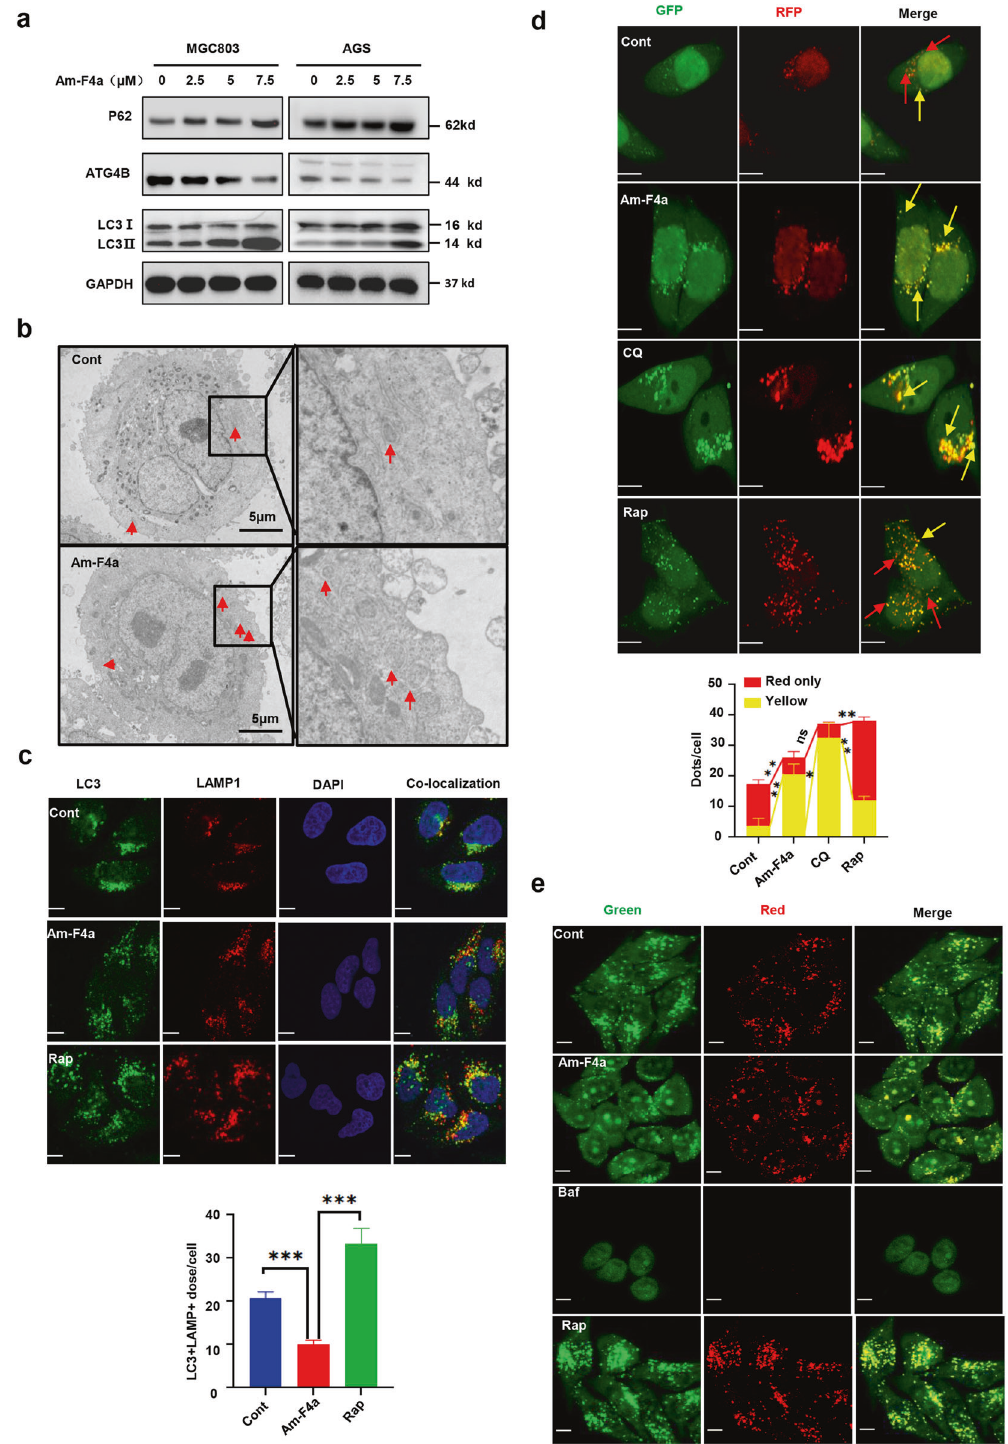
Fig. 3 Am-F4a suppresses autophagy fl ux in cells. a Immunoblotting analysis of indicated protein in MGC803 and AGS cells treated with Am- F4a for 48 h. Representative blots, n = 3. b Representative images of transmission electron microscopy (TEM) exhibit ultrastructure of MGC803 cells treated with or without Am-F4a (10 μ M) for 6 h. Red arrows indicate normal autophagosome structures. c Hela cells were treated with Am-F4a (10 μ M) and Rap (1 μ M) for 6 h. The colocalization of LC3 and LAMP1 puncta was examined and quanti fi ed (scale bar, 10 μ m). Data are shown as mean ± SD, n = 3, Student ’ s t test, *** p < 0.001. d Hela cells expressing GFP-RFP-LC3 were treated with Am-F4a (10 μ M) 、 Rap (1 μ M) and CQ (40 μ M) for 6 h. The colocalization of GFP and RFP puncta was examined and quanti fi ed. Red arrows indicate GFP- or LC3-positive structure, yellow arrows indicate the colocalization of GFP and RFP. Fluorescence images of cells were recorded with fi xation (scale bar, 10 μ m). Data are shown as mean ± SD, n = 3, Student ’ s t test, * p < 0.05, ** p < 0.01, *** p < 0.001. e Acridine Orange (AO) can indicate normal autolysosome structures of cells. Hela cells were treated with Am-F4a (10 μ M), Rap (1 μ M), Baf (0.5 μ M) for 4 h, followed by AO (0.5 μ g/mL) for 30 min. Fluorescence images of live cells were recorded without fi xation (scale bar, 10 μ m).